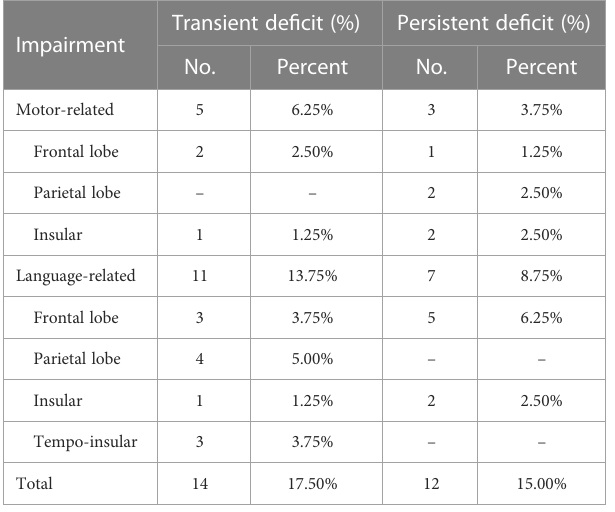
TABLE 3 Distribution of patients with transient and persistent neurological de fi